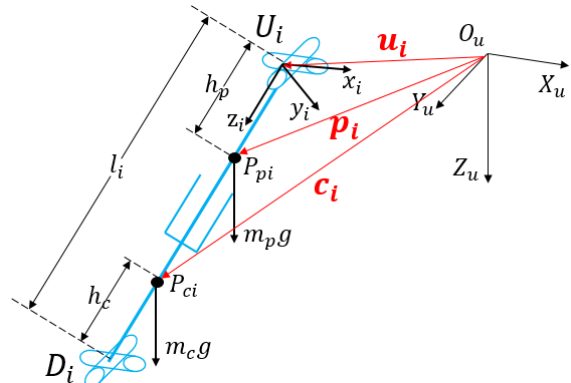
Figure 6. Dimensions and the drive support chain ’ s frame.